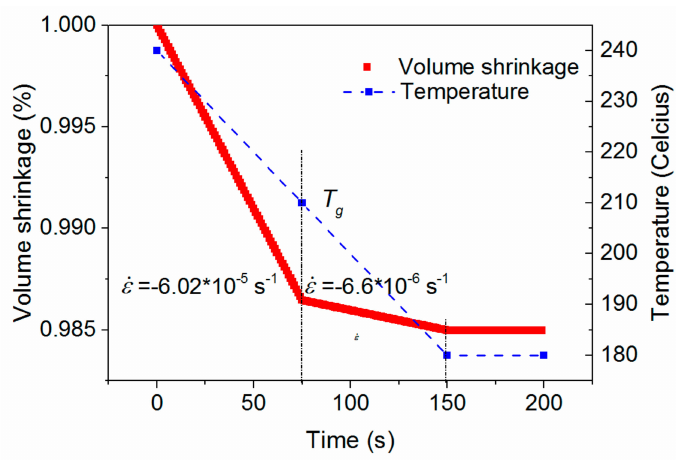
Figure 5. Temperature profile and corresponding volume shrinkage in the slow cooling